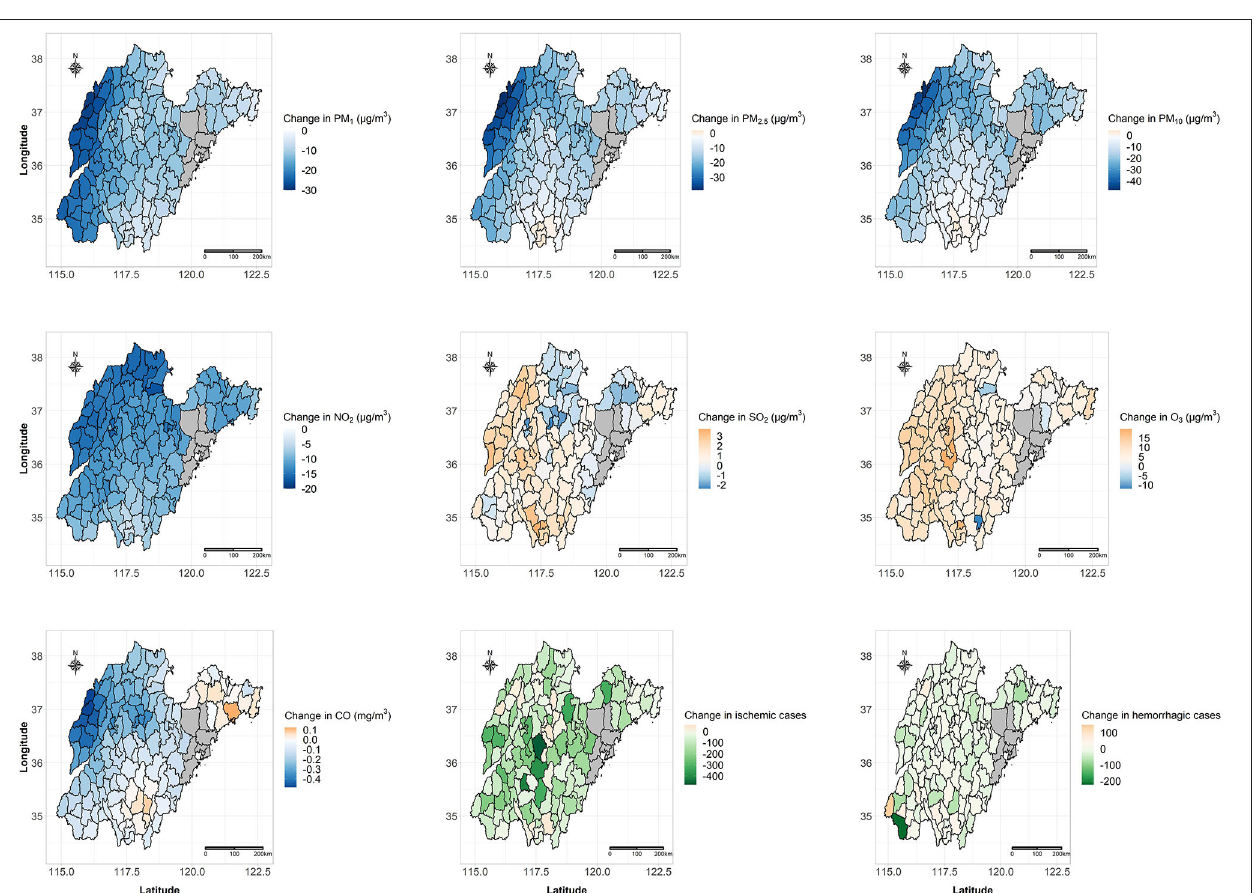
( Table 3 ). The total avoided PM 1 -, PM 2.5 -, PM 10 -, NO 2 -, and CO–related ischemic stroke cases were 739 (95% CI : 641,